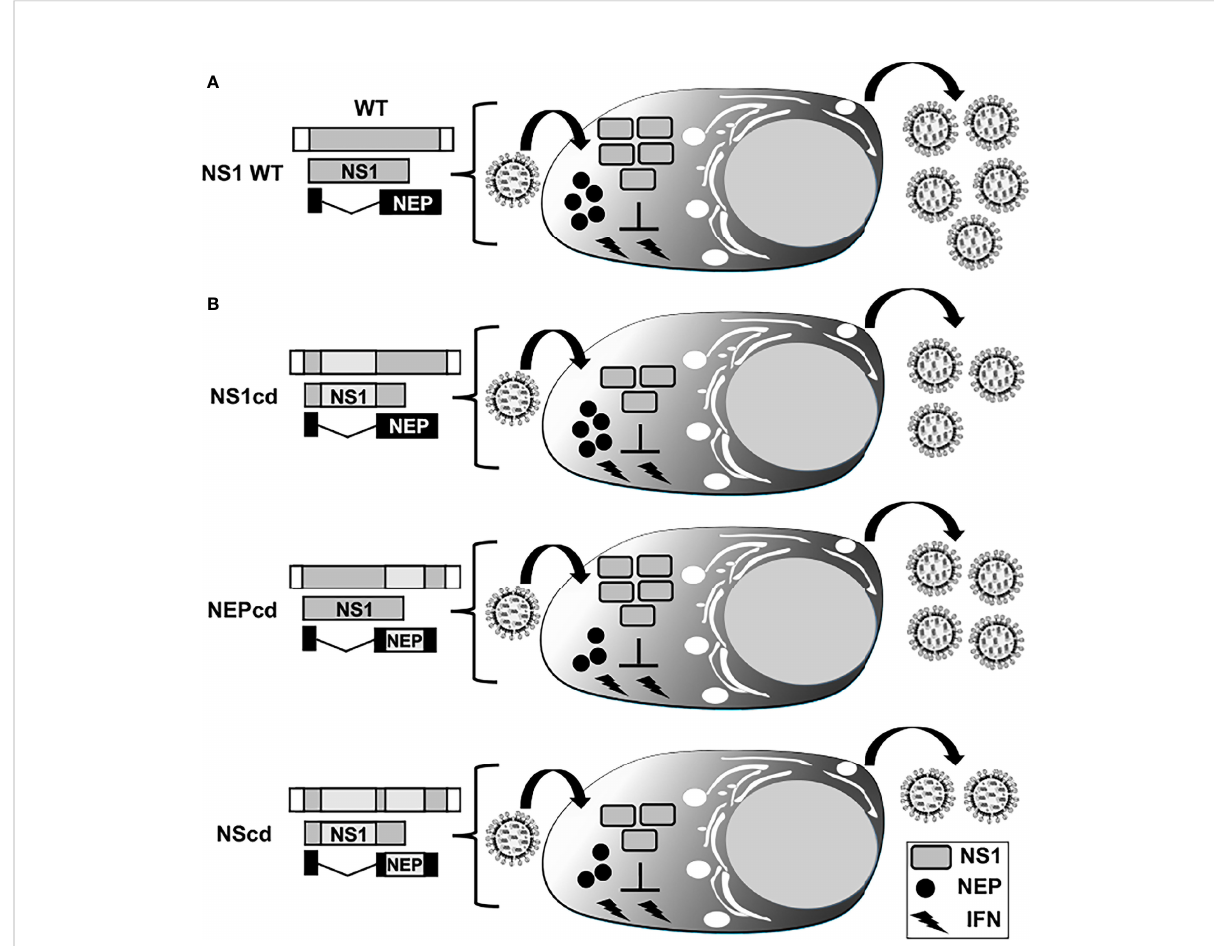
FIGURE 8 Codon deoptimization of NS segment for the generation of LAIV. Schematic representation of WT (A) and codon deoptimized, cd (B) viral NS segments. NS vRNA is represented in gray boxes and the NCR located at the 3´and 5´ ends of the NS vRNA are indicated with white boxes. WT NS1 and NEP ORFs are represented as gray and black boxes, respectively. The cd region is represented with light gray boxes for viruses encoding cd NS1 (NS1cd, top), NEP (NEPcd, middle) or both NS1 and NEP (NScd, bottom) proteins. After infection with an IAV encoding a WT NS segment, expression of full-length NS1 results in inhibition of IFN induction, allowing ef fi cient viral replication (A) . Infection with IAV NS1cd (top, (B) results in reduced NS1 protein expression and inef fi cient inhibition of IFN responses, resulting in reduced viral replication. Infection with IAV NEPcd (middle, (B) results in lower expression of NEP, affecting viral replication. Infection with IAV NScd (bottom, (B) results in the virus showing higher attenuation, correlating with the amount of codon changes introduced in both NS1 and NEP in the modi fi ed NS viral